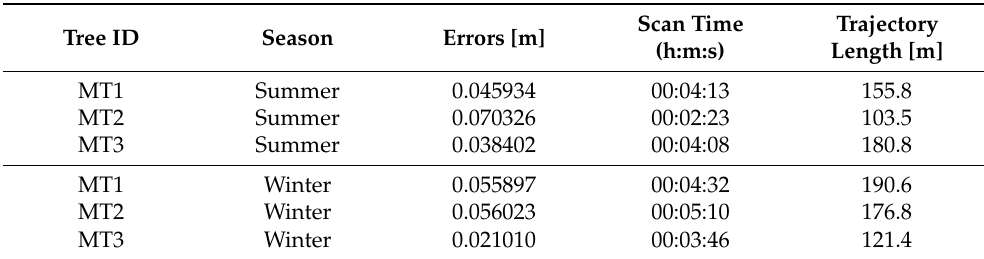
Table 2. Errors in meters, scan time and trajectory length of the MLS point clouds in both winter and summer surveys.